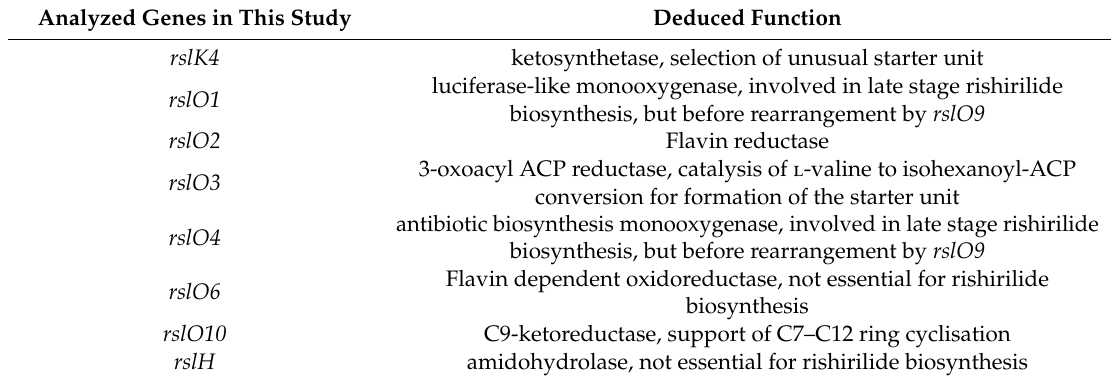
Table 2. Genes discussed in this study and their deduced